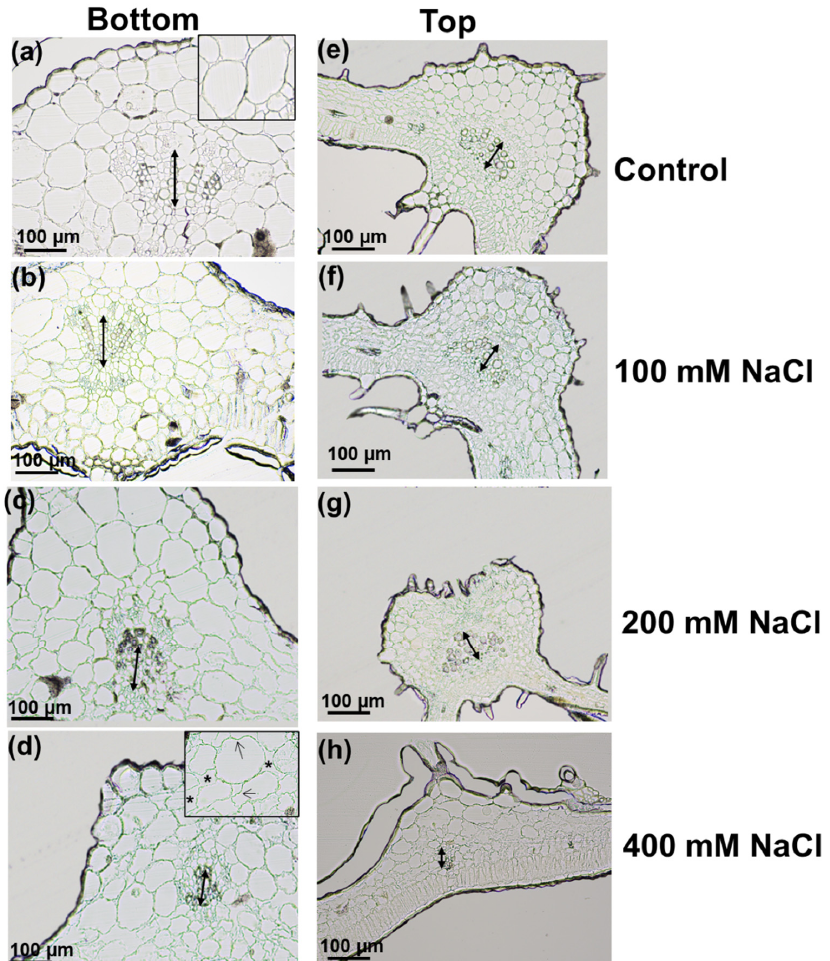
Figure 4. Microtome sections of bottom ( a – d ) and top ( e – h ) leaflets of Micro-Tom plants under control conditions and exposed to 100 mM, 200 mM, 400 mM NaCl. The region corresponding to the central vein is shown. The double-headed arrow shows the xylem. The asterisks and arrows in the inset in ( d ) refer to the intercellular spaces and cell walls’ invaginations. The palisade layer in bottom leaflets was normally constituted by a single layer of elongated cells (Figure 5a). In the bottom leaflets under high salt levels (200 and 400 mM),